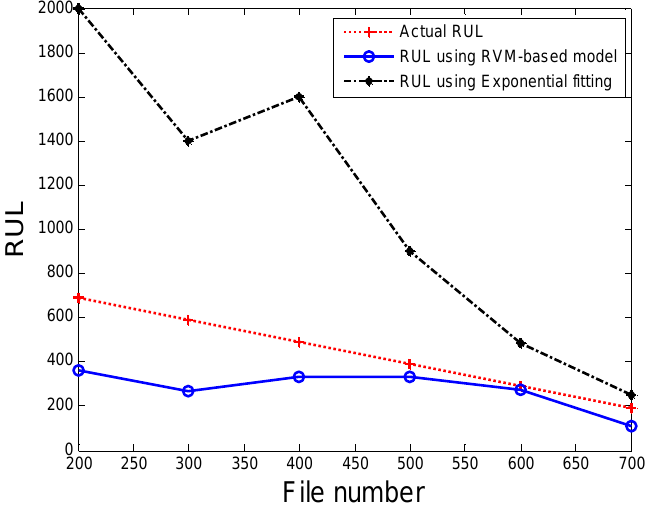
Figure 14. Comparison of prognosis performance using the RVM-based model and exponential fitting for dataset T2G1C3